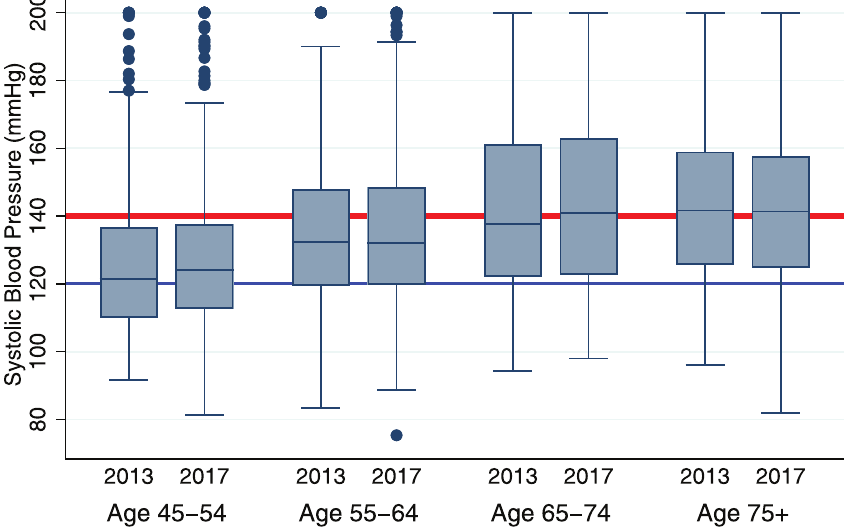
Fig 2. Systolic blood pressure (mmHg) among mature adults in 2013 and 2017, by age in 2013. Notes : Analyses include all MLSFH-MAC respondents with both 2013 and 2017 BP measurement. Age group is assigned based on age in 2013. Systolic BP is top-coded at 200 mmHg. The corresponding graph for diastolic BP is reported in S1 Fig. S2 and S3 Figs provide analyses separate for men and